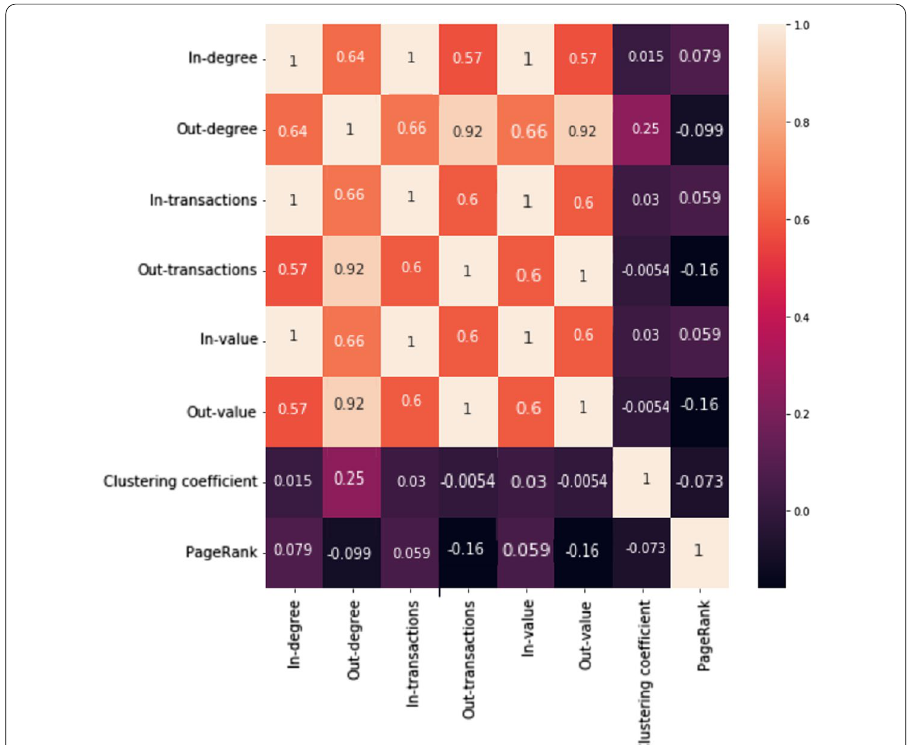
Fig. 7 Correlation matrix for the spectrum features of the class “Exchange”